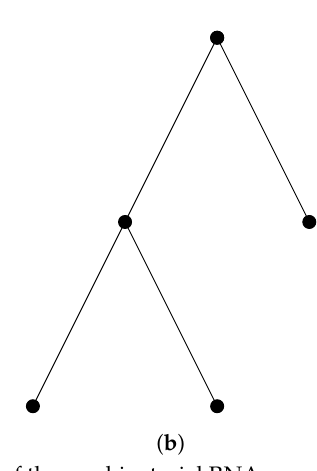
Figure 1. A ribonucleic acid (RNA) secondary structure for one of the combinatorial RNA sequences used in this work and its corresponding plane tree. The ordering of the edges in the plane tree is derived from the 3’ to 5’ ordering of the RNA sequence. Note that the exterior loop corresponds to the root of the plane tree. The diagram in ( a ) was generated by ViennaRNA [19]. ( a ) A maximally-paired secondary structure for A 4 ( C 5 GA 4 CG 5 A 4 ) 4 has 4 helices; ( b ) The corresponding plane tree has 4 edges and encodes the branching pattern seen in the secondary